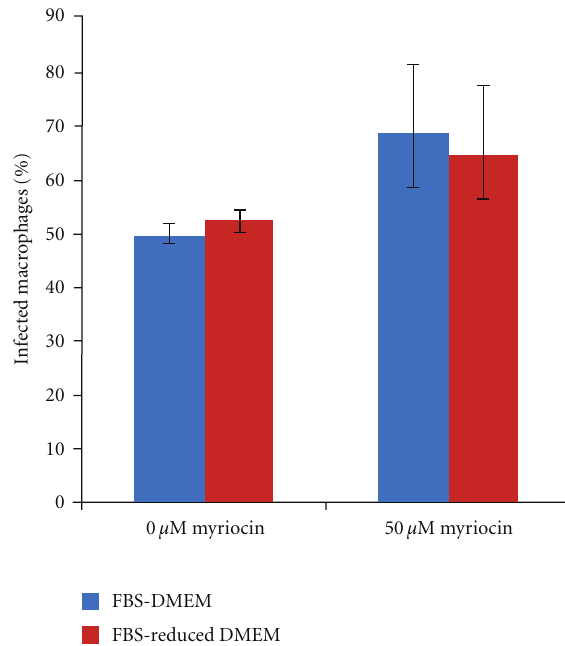
Figure 3: Invasion, % infected macrophages, determined 48 hours after infection in the presence or absence of the SPT inhibitor myri- ocin and with (FBS-DMEM) or without (FBS-reduced DMEM) exogenous serum in the media. Results of three independent